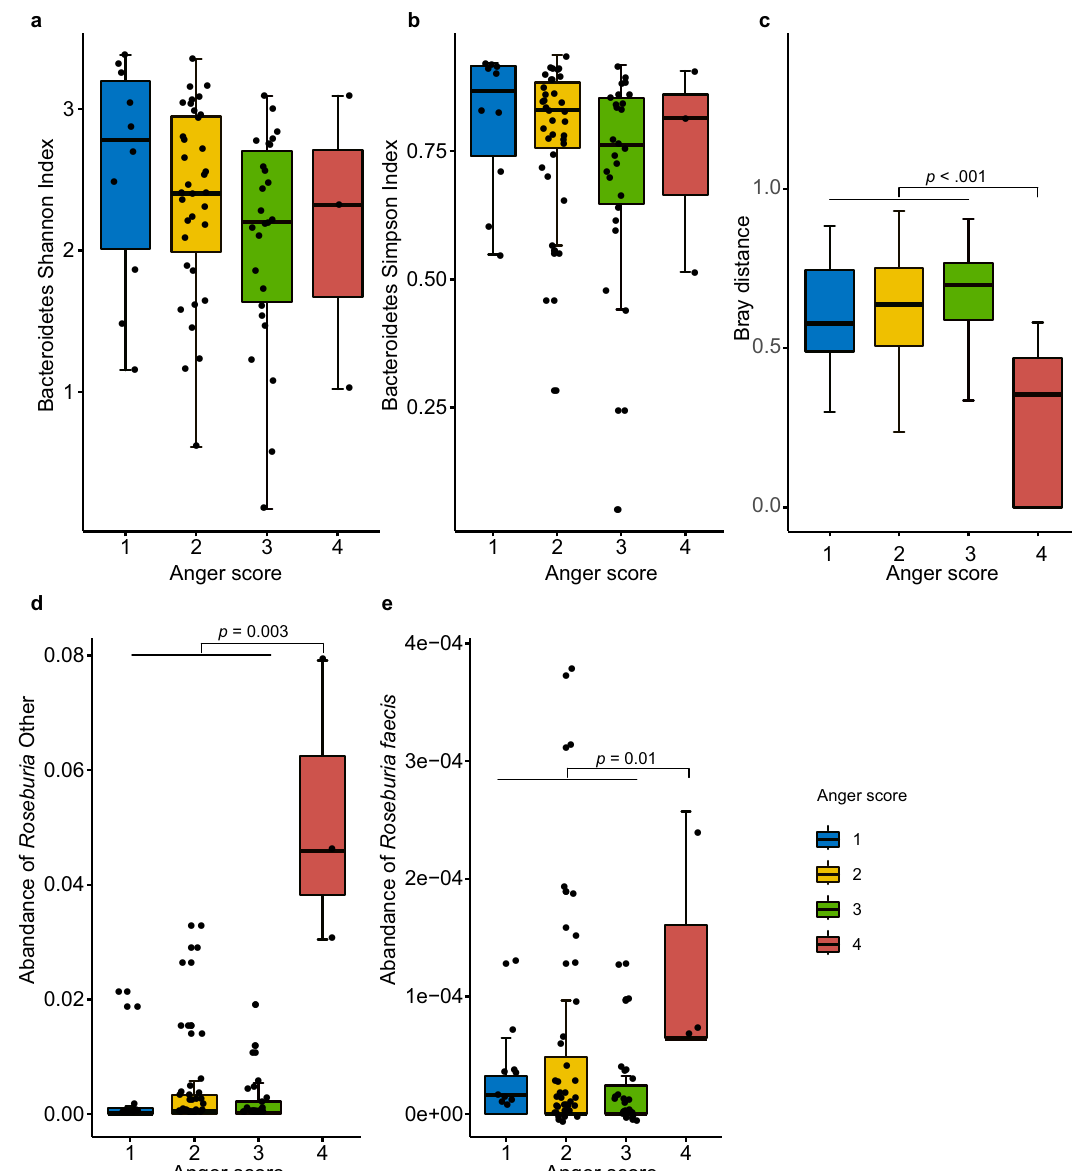
Figure 5. Associations between gut microbiota and Anger frequency. ( a ) Association between Shannon index of Bacteroidetes and anger frequency. ( b ) Association between Simpson index of Bacteroidetes and anger frequency. ( c ) Association between bray distance of species level and anger frequency. ( d ) Association between the abundance of Roseburia Other species and anger frequency. ( e ) Association between the abundance of Roseburia faecis species and anger frequency. Four colours indicated four degrees of anger